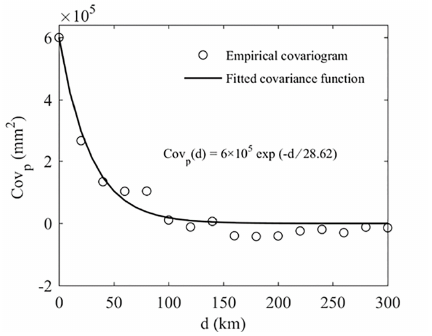
Figure 4. Empirical covariogram (Cov e ( d )) from the sub-basin runoff data and theoretical covariogram by the fitted covariance function Cov p (d) of the study area.